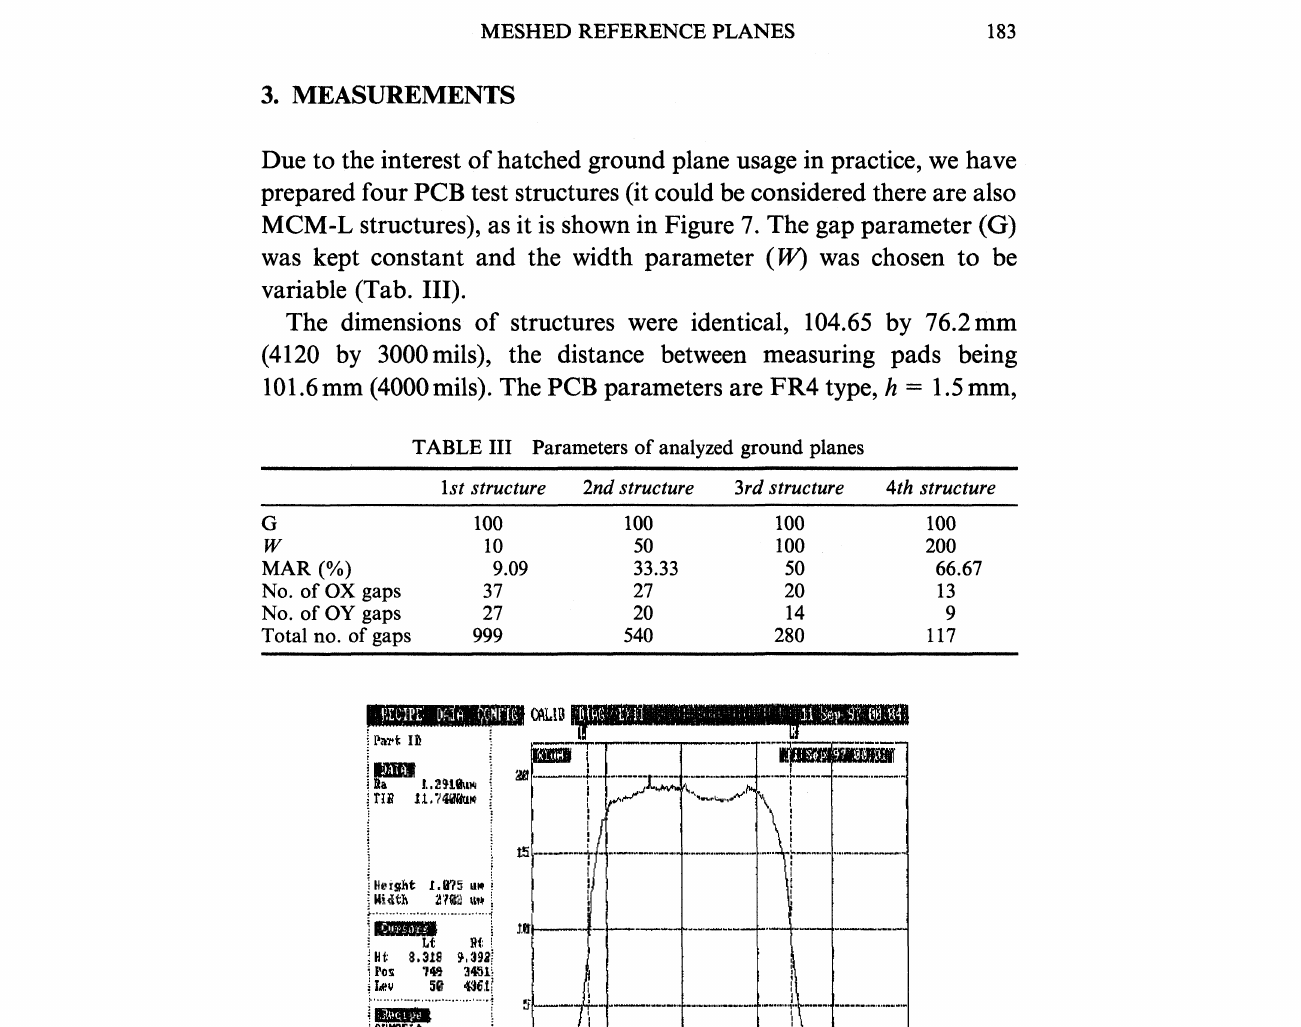
FIGURE 8 Measurement of track